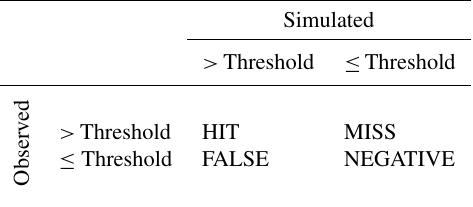
Table 2. Contingency table used to calculate probability of detec- tion (POD) and false alarm ratio (FAR) at a given rainfall